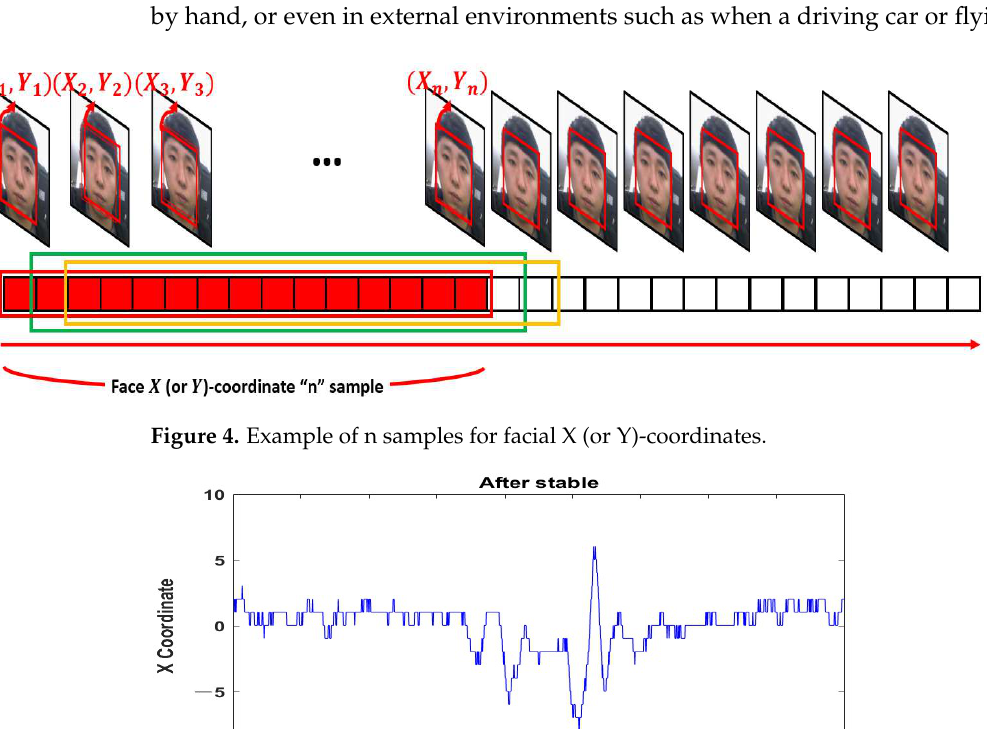
Figure 5. Calibrated coordinate result (n = 15).